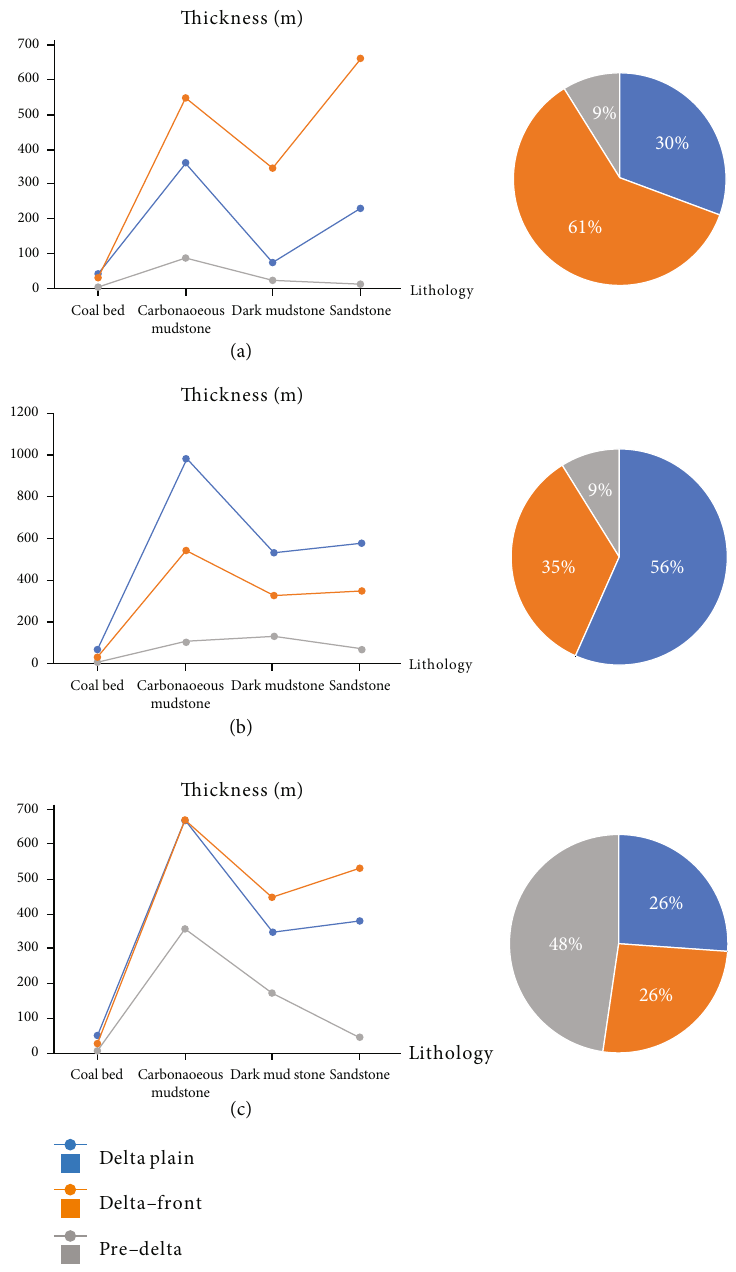
Figure 9: The relationship between content of source rock, sandstone, and sedimentary subfacies: (a) depositional thickness of various lithologies and distribution of study wells in various sedimentary subfacies during the T32 period; (b) depositional thickness of various lithologies and distribution of study wells in various sedimentary subfacies during the T33 period; (c) depositional thickness of various lithologies and distribution of study wells in various sedimentary subfacies during the T34